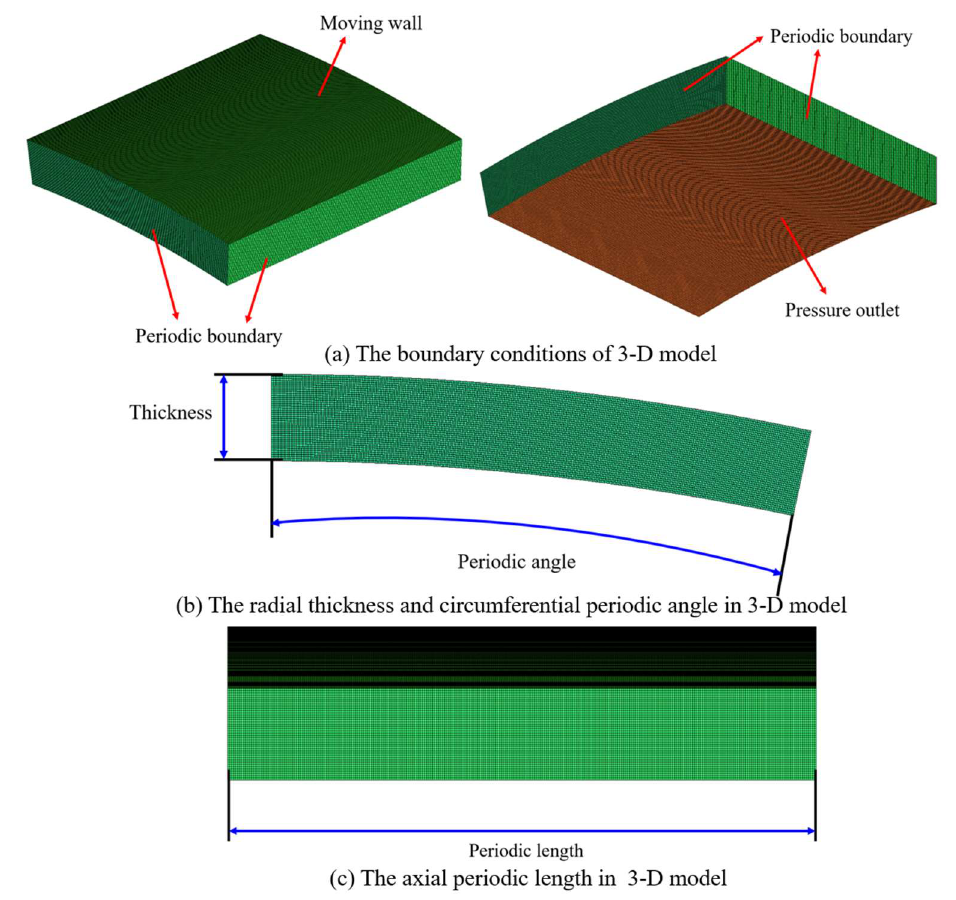
Figure 5. The mesh and boundary conditions of the three-dimensional model.